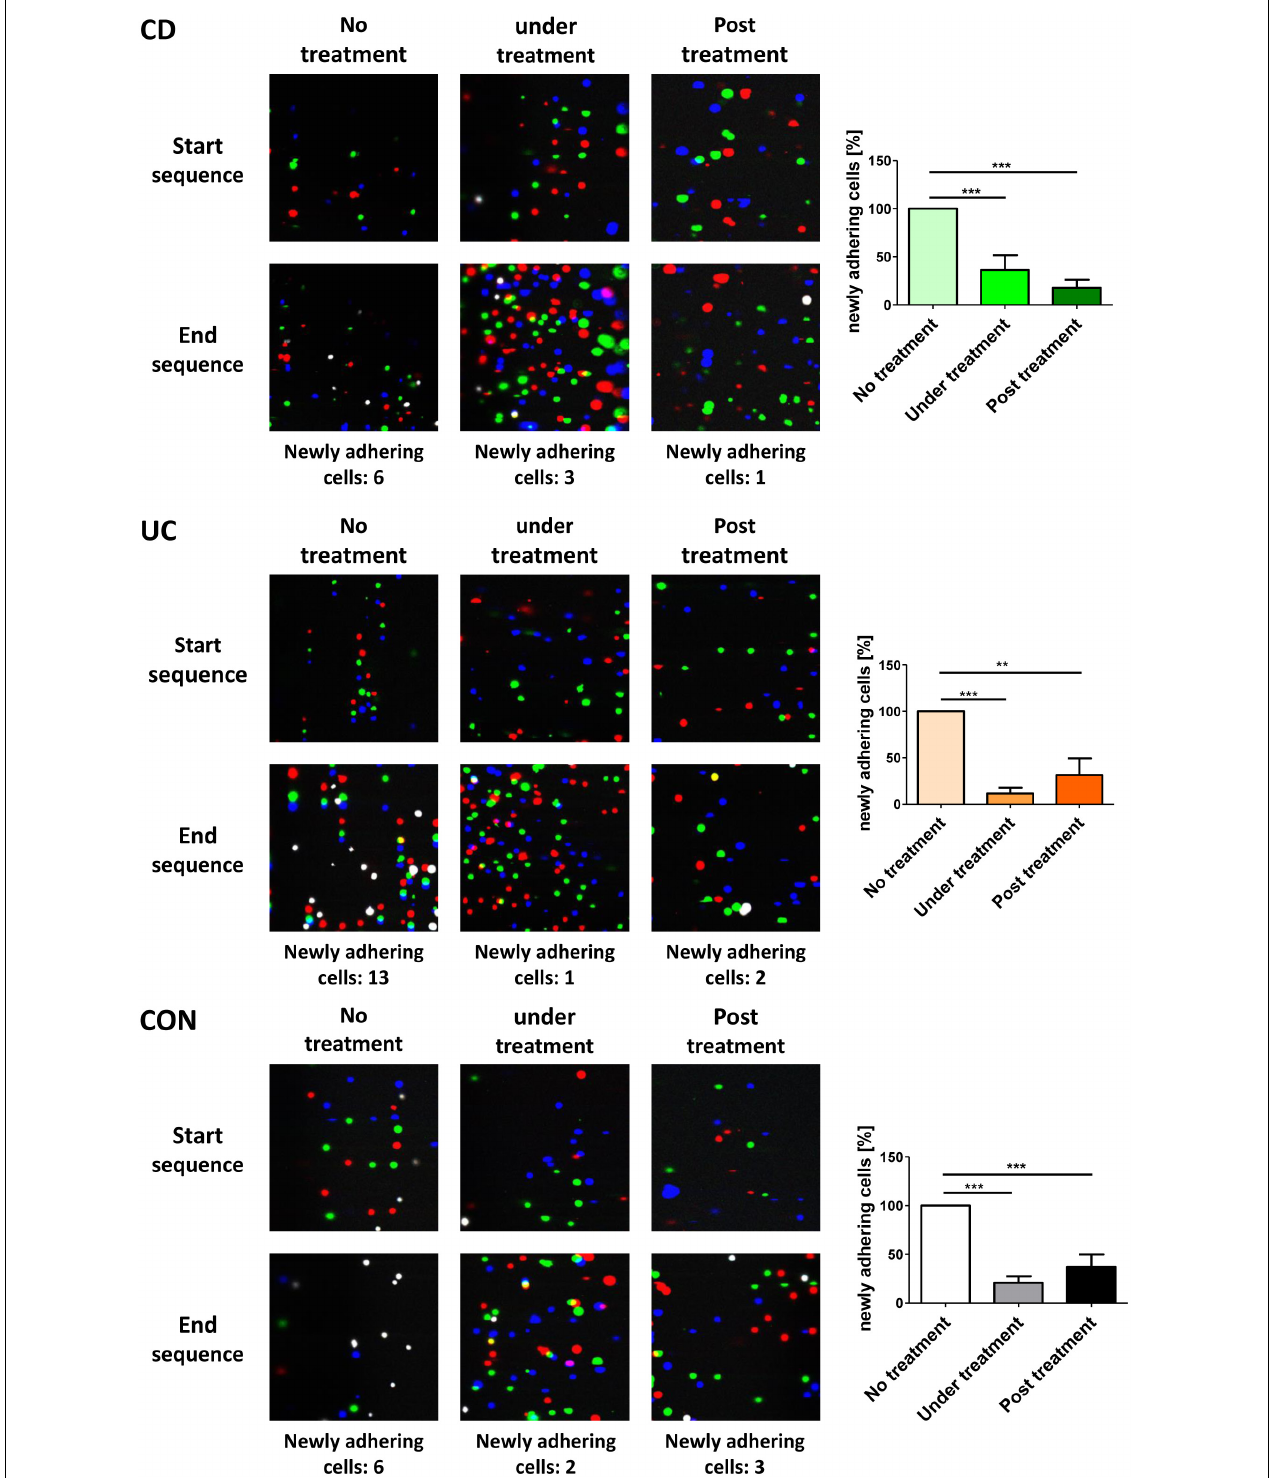
FIGURE 5 | Internalization of β 7 integrin functionally leads to decreased dynamic adhesion to MAdCAM-1. Dynamic adhesion assays with untreated PBMCs, PBMCs pre-treated with etrolizumab-s for 24 h or treated with etrolizumab-s during the assay. Left panels: Representative overlays of three differentially colored sequential images collected at the beginning or end of 3 min clips. White cells represent adhering cells. Right panels: Quantitative data normalized to untreated PBMCs (CD n = 8, UC n = 5, and CON n = 5). ∗∗ p < 0.01, ∗∗∗ p < 0.001.